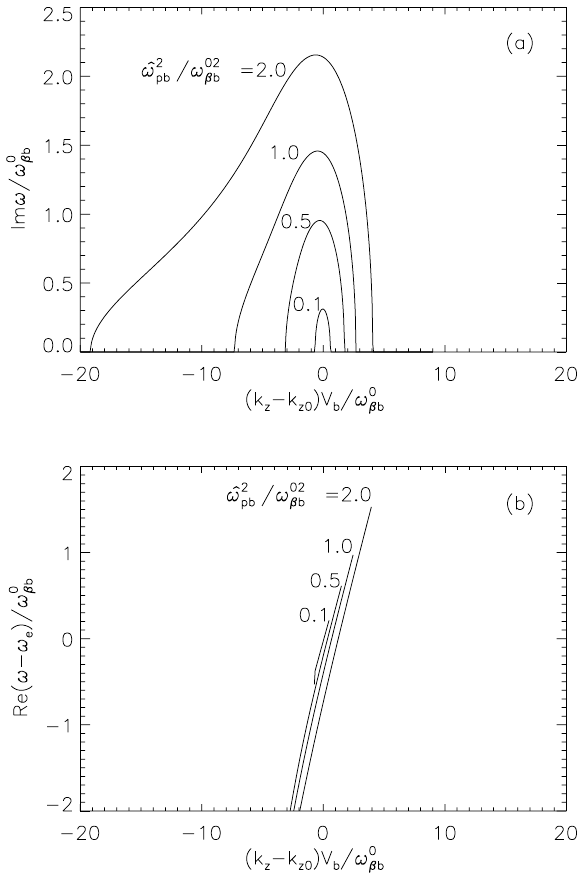
FIG. 7. Plots of (a) normalized growth rate Im v (cid:121) v (cid:48) b (cid:98) and (b) normalized real frequency (cid:115) Re v 2 v (cid:101) (cid:100)(cid:121) v (cid:48) b (cid:98) versus shifted axial wave number (cid:115) (cid:107) (cid:122) 2 (cid:107) (cid:122) (cid:48) (cid:100) (cid:86) (cid:98) (cid:121) v (cid:48) b (cid:98) obtained numerically from the full dispersion relation (91) for the unstable branch with positive real frequency. System parameters correspond to (cid:90) (cid:98) (cid:173) (cid:49) , (cid:109) (cid:98) (cid:121) (cid:109) (cid:112) (cid:173) (cid:50)(cid:48)(cid:48) , (cid:115) g (cid:98) 2 (cid:49) (cid:100) (cid:109) (cid:98) (cid:99) (cid:50) (cid:173) (cid:49)(cid:48) GeV, (cid:114) (cid:98) (cid:121) (cid:114) (cid:119) (cid:173) (cid:48)(cid:46)(cid:53) , (cid:102) (cid:173) (cid:48)(cid:46)(cid:49) , and v (cid:48) b (cid:101) (cid:173) (cid:48) . Curves are shown for